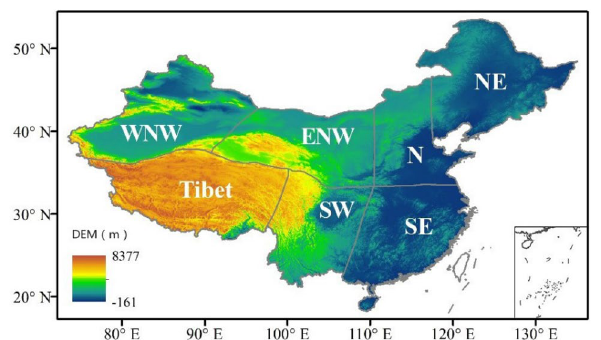
Figure 1. Elevation map and seven climatic divisions of China (ArcGIS Desktop. 10.0. ESRI, California, US. https:// deskt op. arcgis. com/ zh-